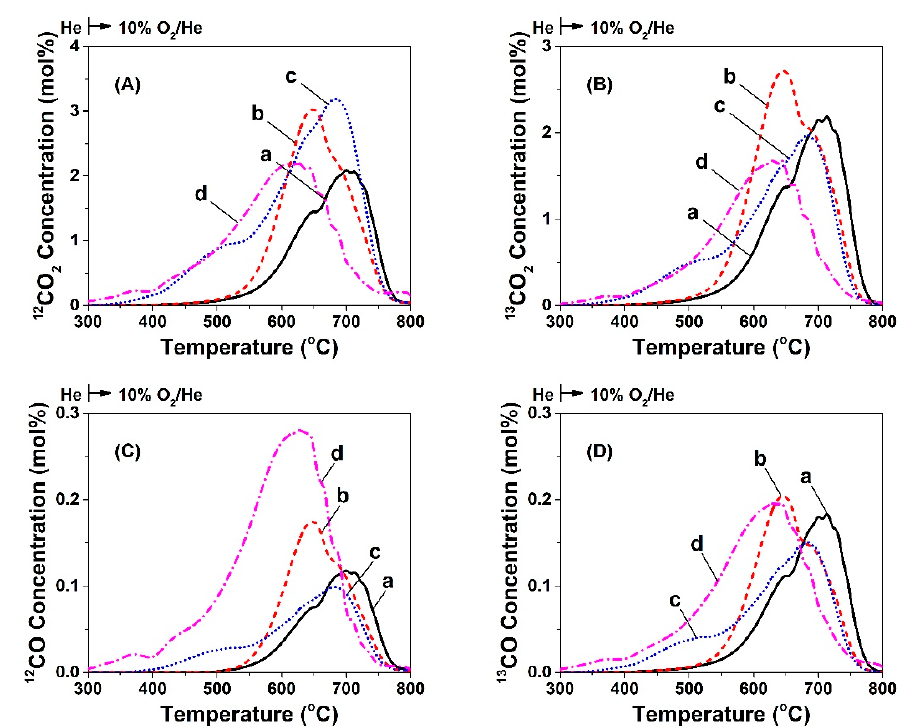
Figure 7. Temperature-programmed oxidation (TPO) of carbon to 12 C- and 13 C-containing CO 2 ( A , B ) and CO ( C,D ) formed after 20 min in 2.5 vol% 13 CO / 2.5 vol% 12 CH 4 / 2 vol% Kr / Ar / He (50 NmL min − 1 ; GHSV ~30,000 h − 1 ) at 750 ◦ C over 5 wt% Ni / CeO 2 prepared by (a) Thermal decomposition (TD), (b) Precipitation (PT), (c) Hydrothermal (HT), and (d) Sol-gel (SG) method. Table 3. Quantity of 12 CO, 13 CO, 12 CO 2 , and 13 CO 2 (mmol g − 1 ) formed during TPO following 20 min of reaction with 2.5 vol% 13 CO / 2.5 vol% 12 CH 4 / 2 vol% Kr / Ar / He at 750 ◦ C over all the Ni / CeO 2